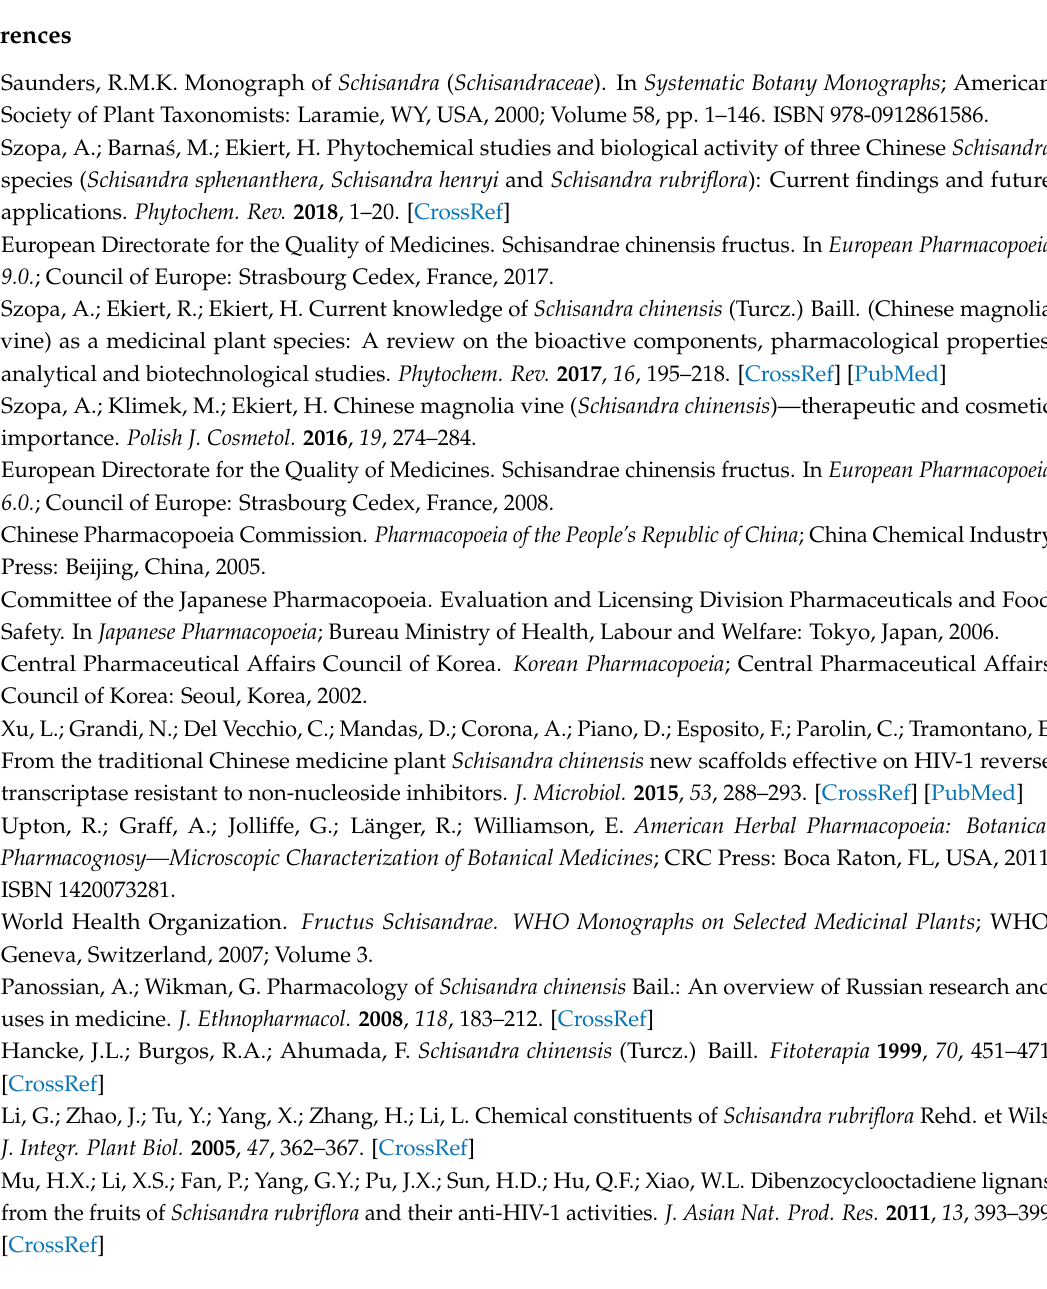
studied lignans. Table S3: Quantitative composition of “average sample lignan composition” (MIX) at 1.75 µ